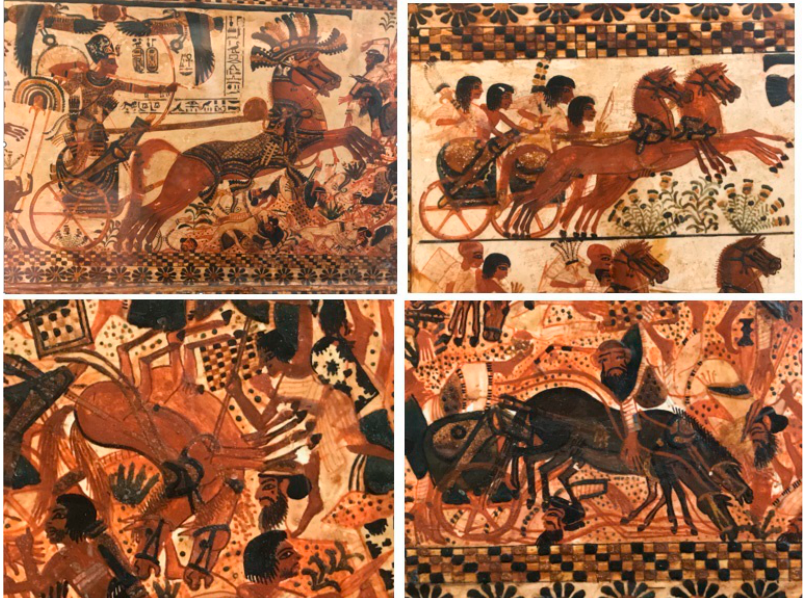
Figure 6. a (top left), b (top right), c (bo tt om left) and d (bo tt om right). Egyptian troops (top) ver-sus enemy troops (bo tt om) on a wooden. Chest belonging to Pharaoh Tutankhamun, 18th dyn-asty. Location: Cairo Museum. Inv. no. JE 61467. Photo: Lonneke Delpeut.